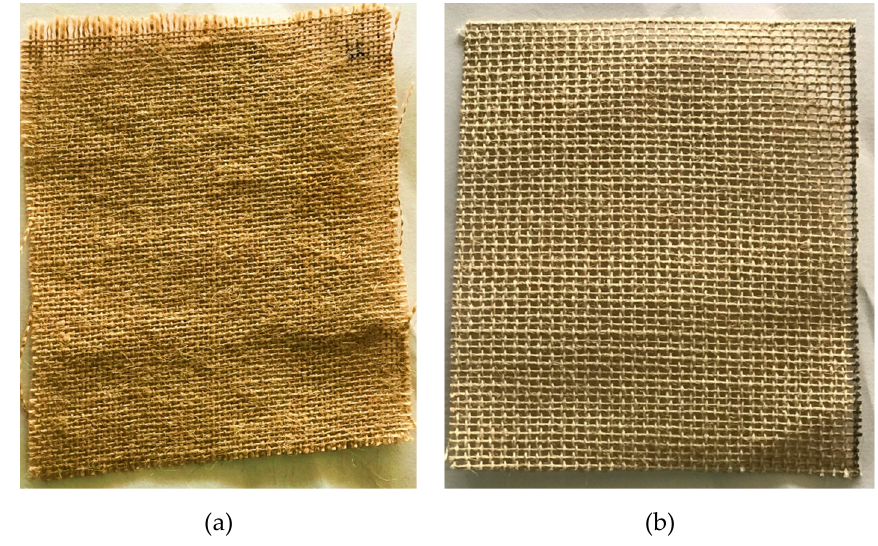
Figure 1. Bidirectional woven sheet of ( a ) flax fibre ( b ) ramie fibre.